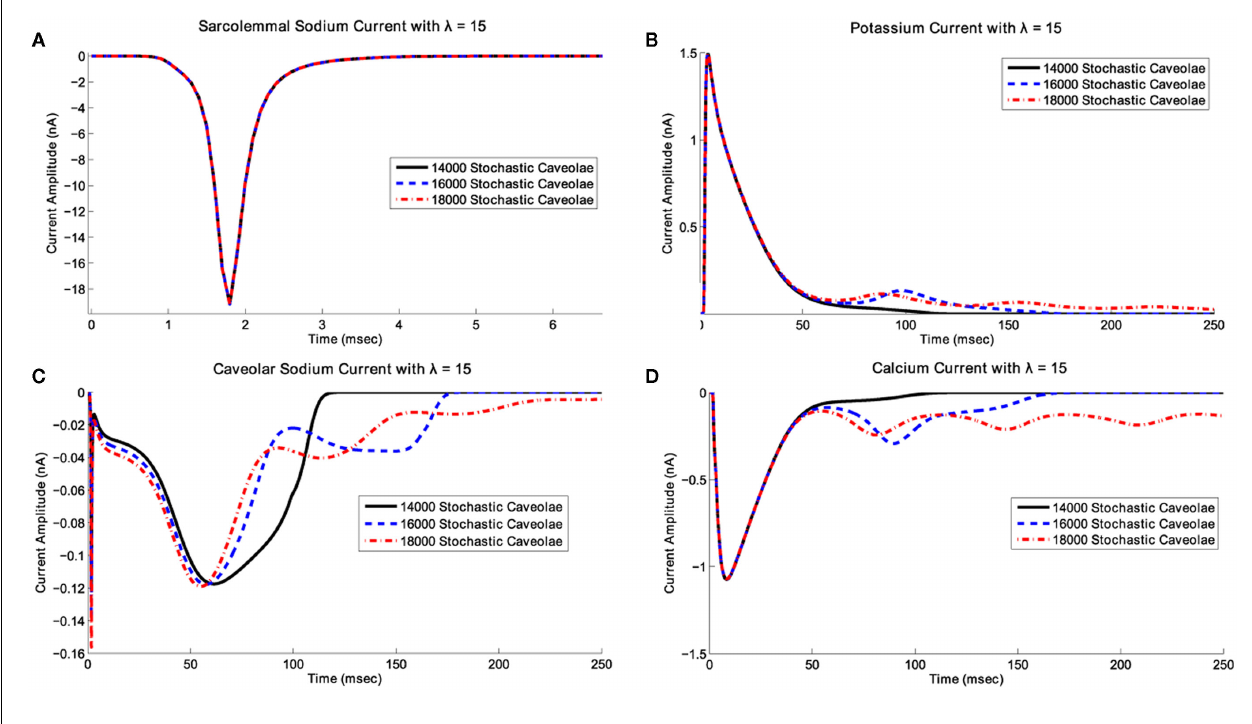
reactivation occurs leading to a single early afterdepolarization with 16000 caveolae and a series of afterdepolarizations with 18000 caveolae. In the case of 18000 caveolae, repolarization is delayed long enough for the slower Na , variables to enter the basin of attraction for a new fixed point and the system settles into a new equilibrium state which may not have any physiological relevance.